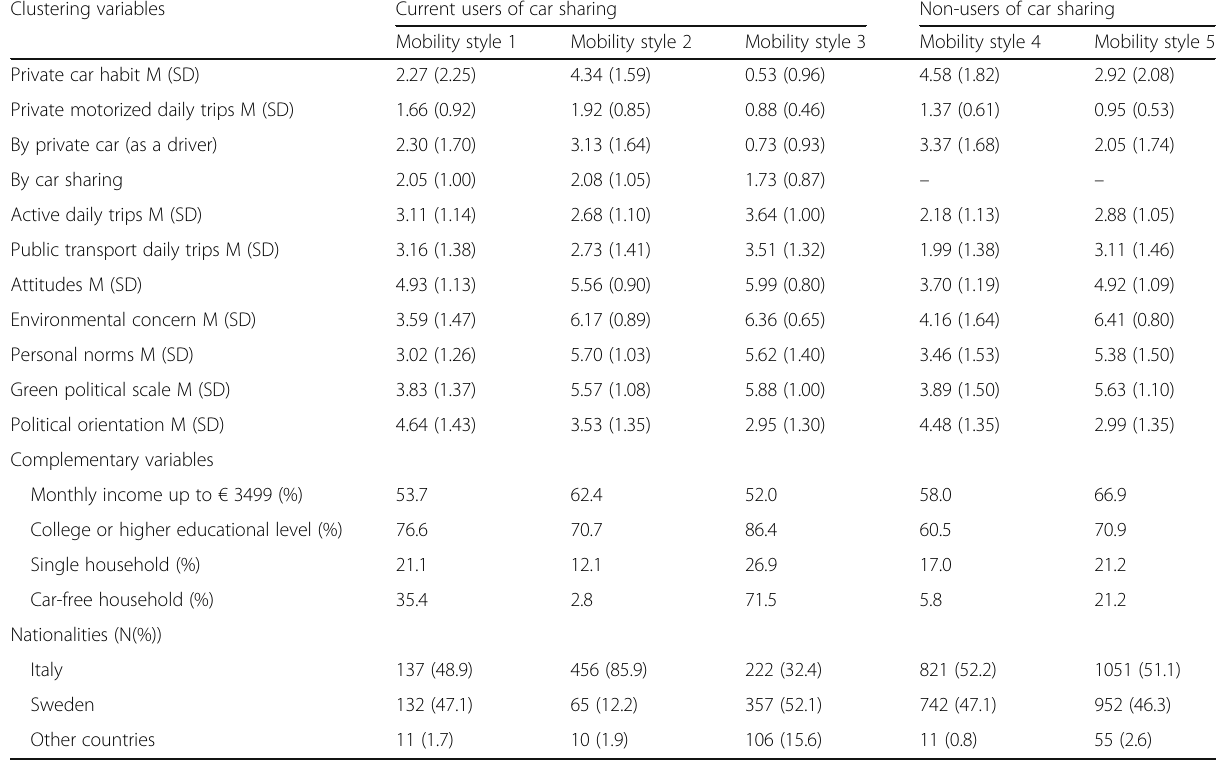
Table 3 Mean values (M) and standard deviations (SD) of clustering and complementary variables by mobility